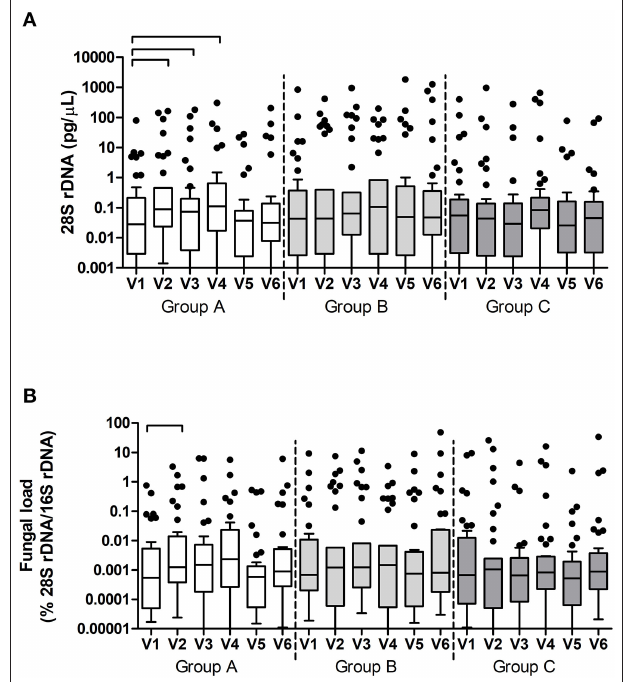
FIGURE 6 | Fungal DNA (28S rDNA) (A) and Fungal load (fungal DNA relative to bacterial DNA) (B) per group and per visit in dental plaque samples. The connectors connect the visits that differed significantly ( P < 0.05, Wilcoxon Signed Ranks test) from the baseline visit.